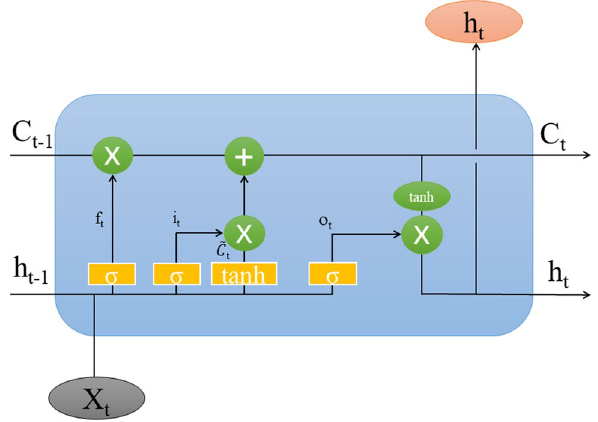
Fig. 3 Structure diagram of the LSTM